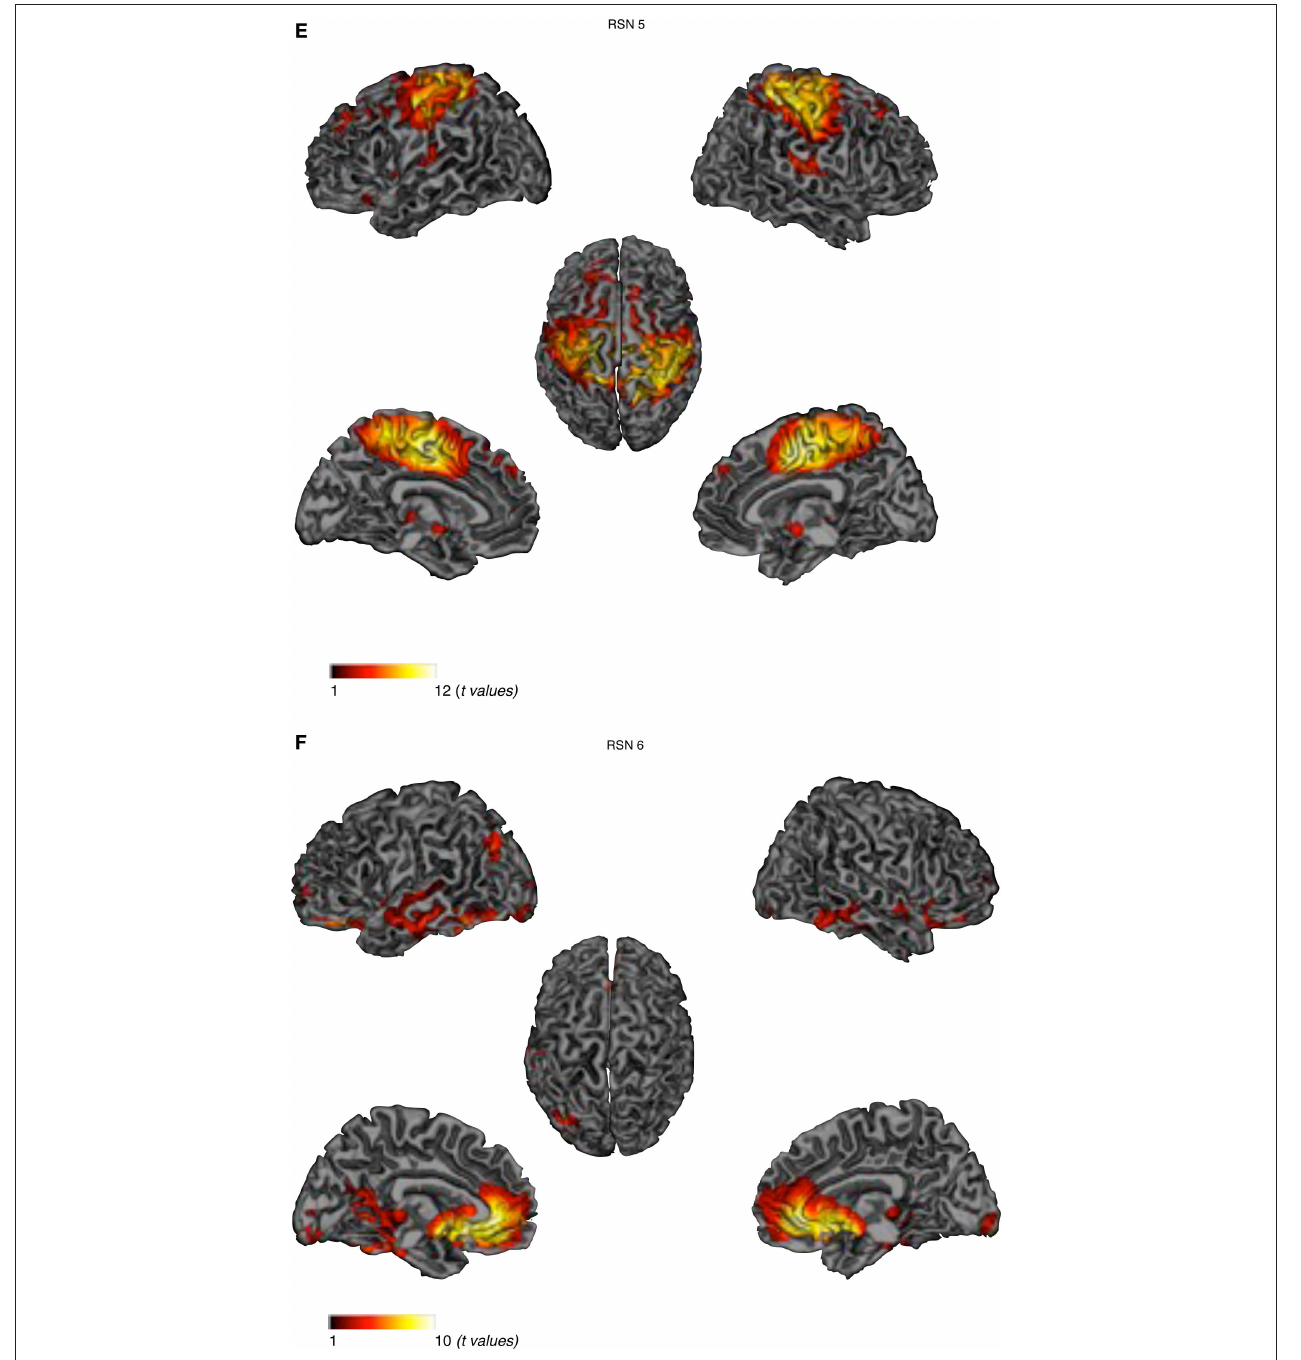
FIguRe 1 | Cortical representation of the activity in the six RSNs. For each RSN (Left) Lateral and medial views of left hemisphere. (Center) Dorsal view. (Right) Lateral and medial views of right hemisphere. (e) sensory motor network – SMN, (F) self-referential network – SRN.